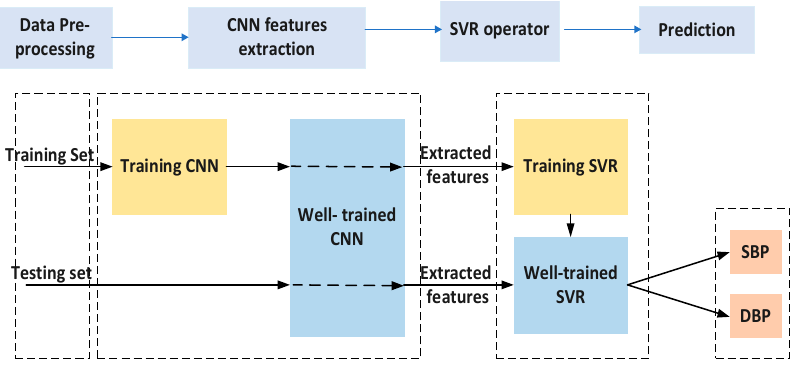
Figure 7. The implementation process of the Hybrid CNN-SVR model.